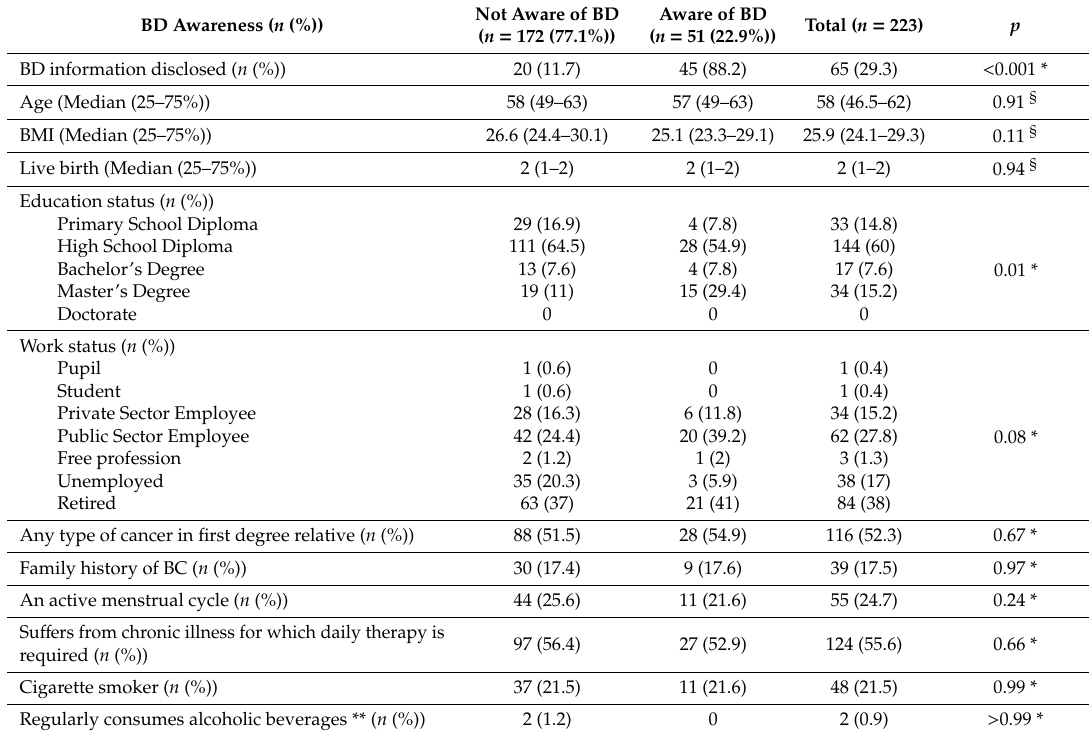
Table 1. Historical and sociodemographic